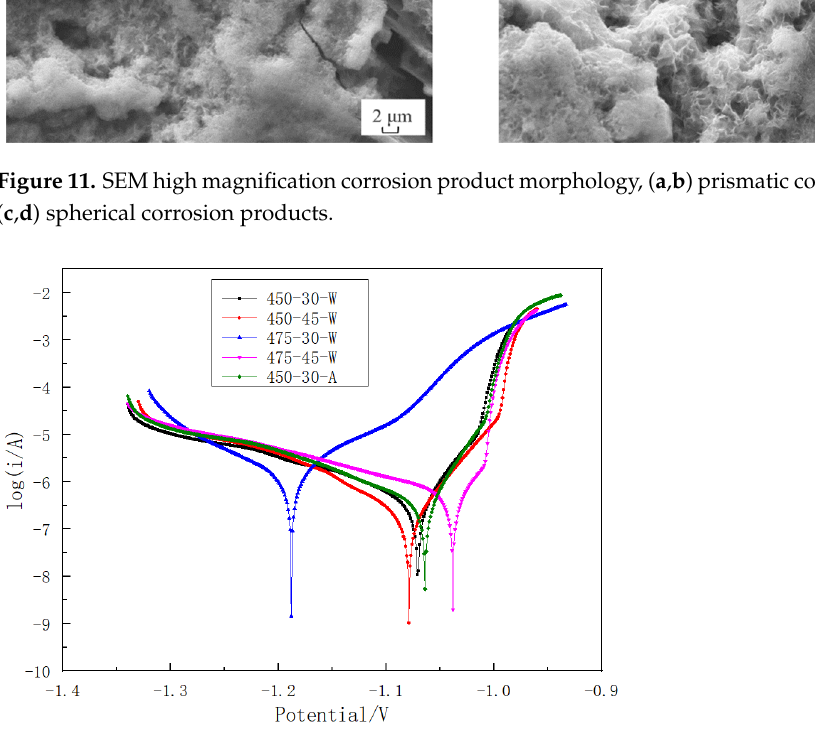
Figure 12. Electrochemical polarization curves of coated steel wires under different processes. Table 11. Electrochemical polarization curve parameters of coated steel wire under different process parameters.